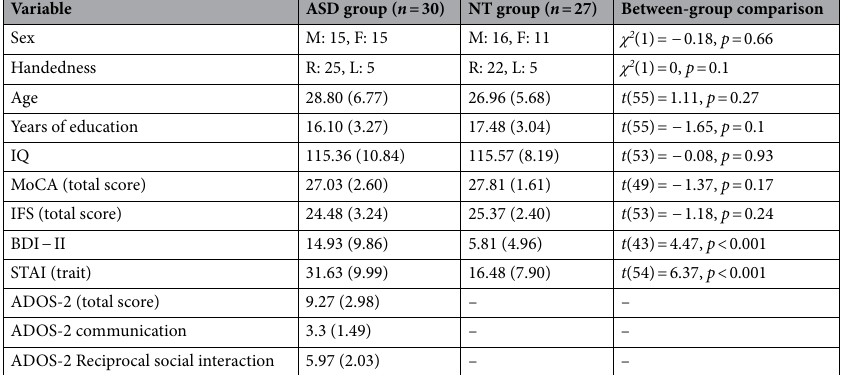
Table 1. Participants’ demographic, cognitive and clinical data. Data are presented as mean ( SD ), except for sex and handedness. IQ was estimated using the vocabulary and matrix reasoning subtests from the Wechsler Abbreviated Scale of Intelligence (WASI-II). Categorical variables were analyzed via Pearson’s chi-squared test. Continuous variables were analyzed with unpaired t test. ADOS-2 autism diagnostic observation schedule-2, AS autism spectrum disorder, BDI-II beck depression inventory-II, IFS INECO frontal screening, L left, MoCA montreal cognitive assessment, NT neurotypical, R right, STAI state-trait anxiety